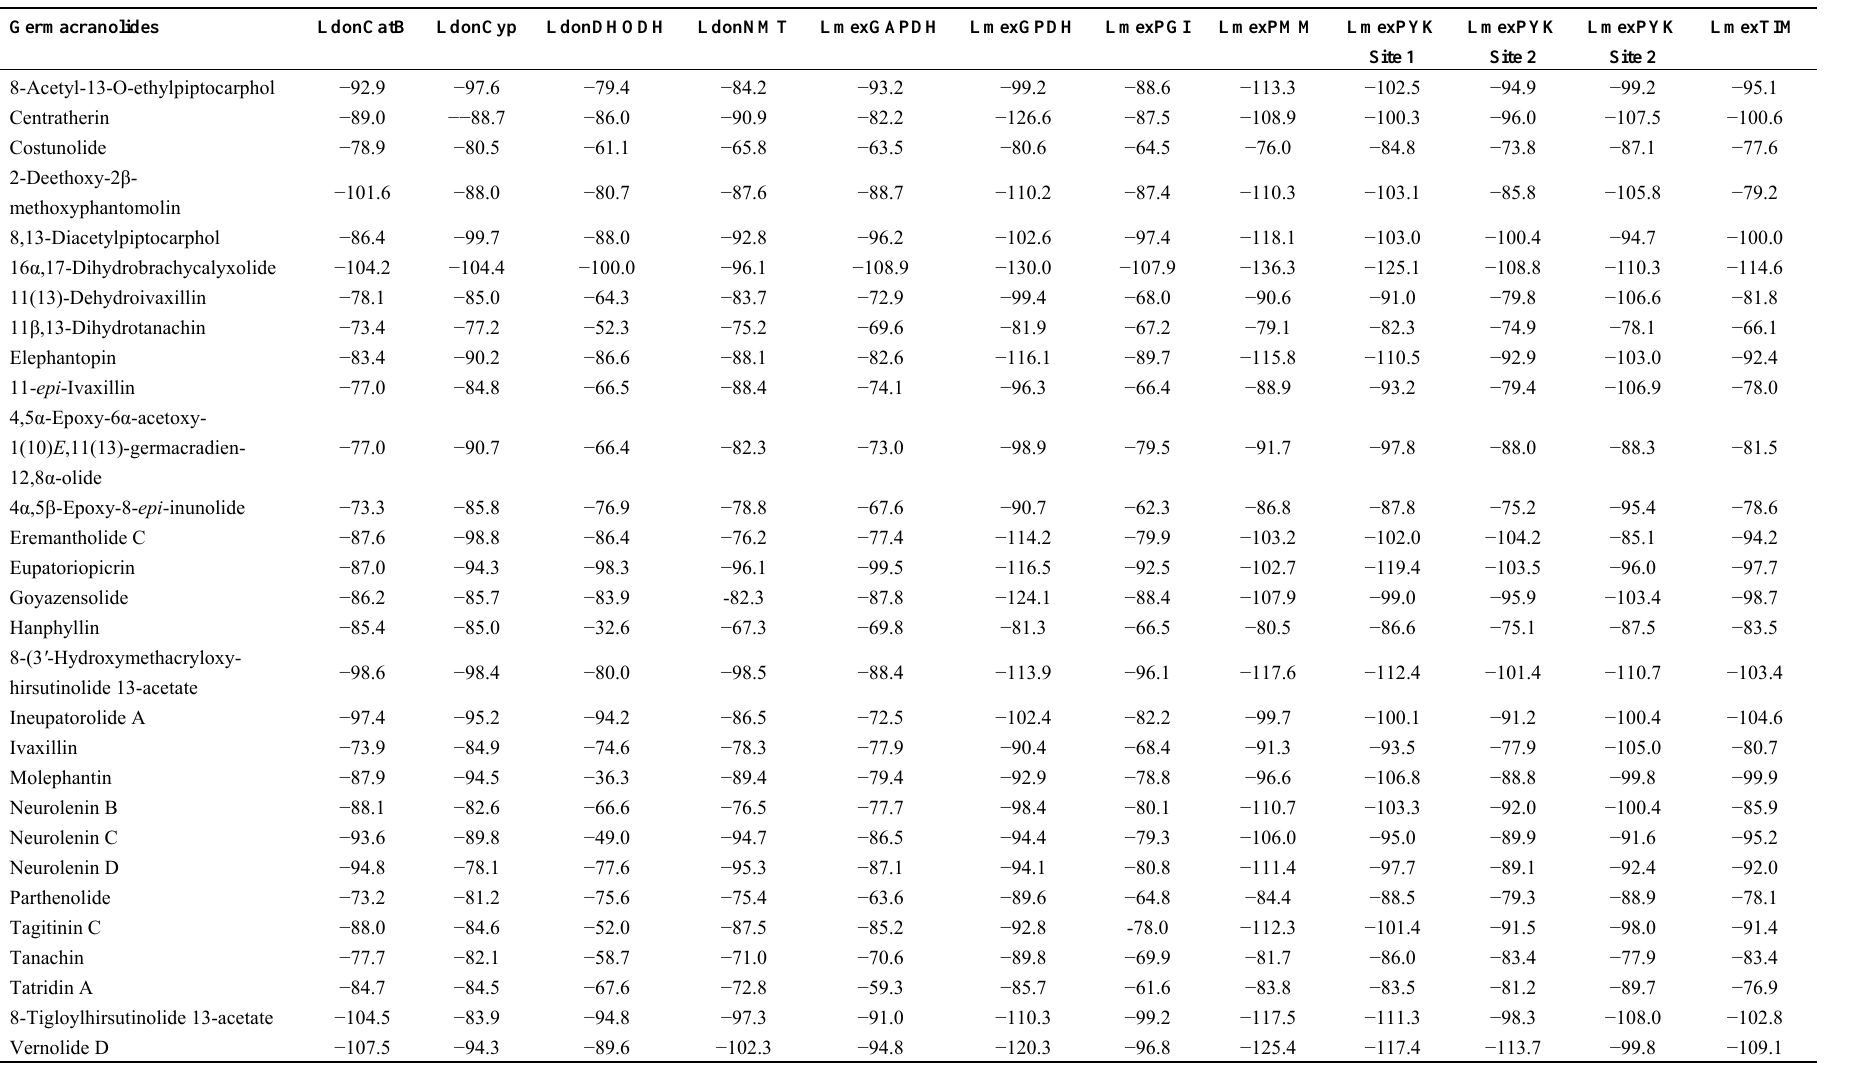
Table 5. MolDock docking energies (kJ/mol) of germacranolide sesquiterpenoids with Leishmania donovani and L. mexicana protein targets.